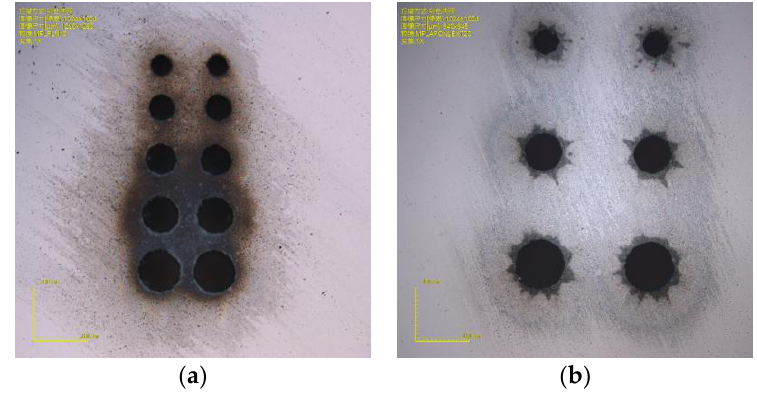
Figure 5. Pictures of via holes on 500-μm Pyrex 7740: ( a ) inlet surface; and ( b ) outlet surface.